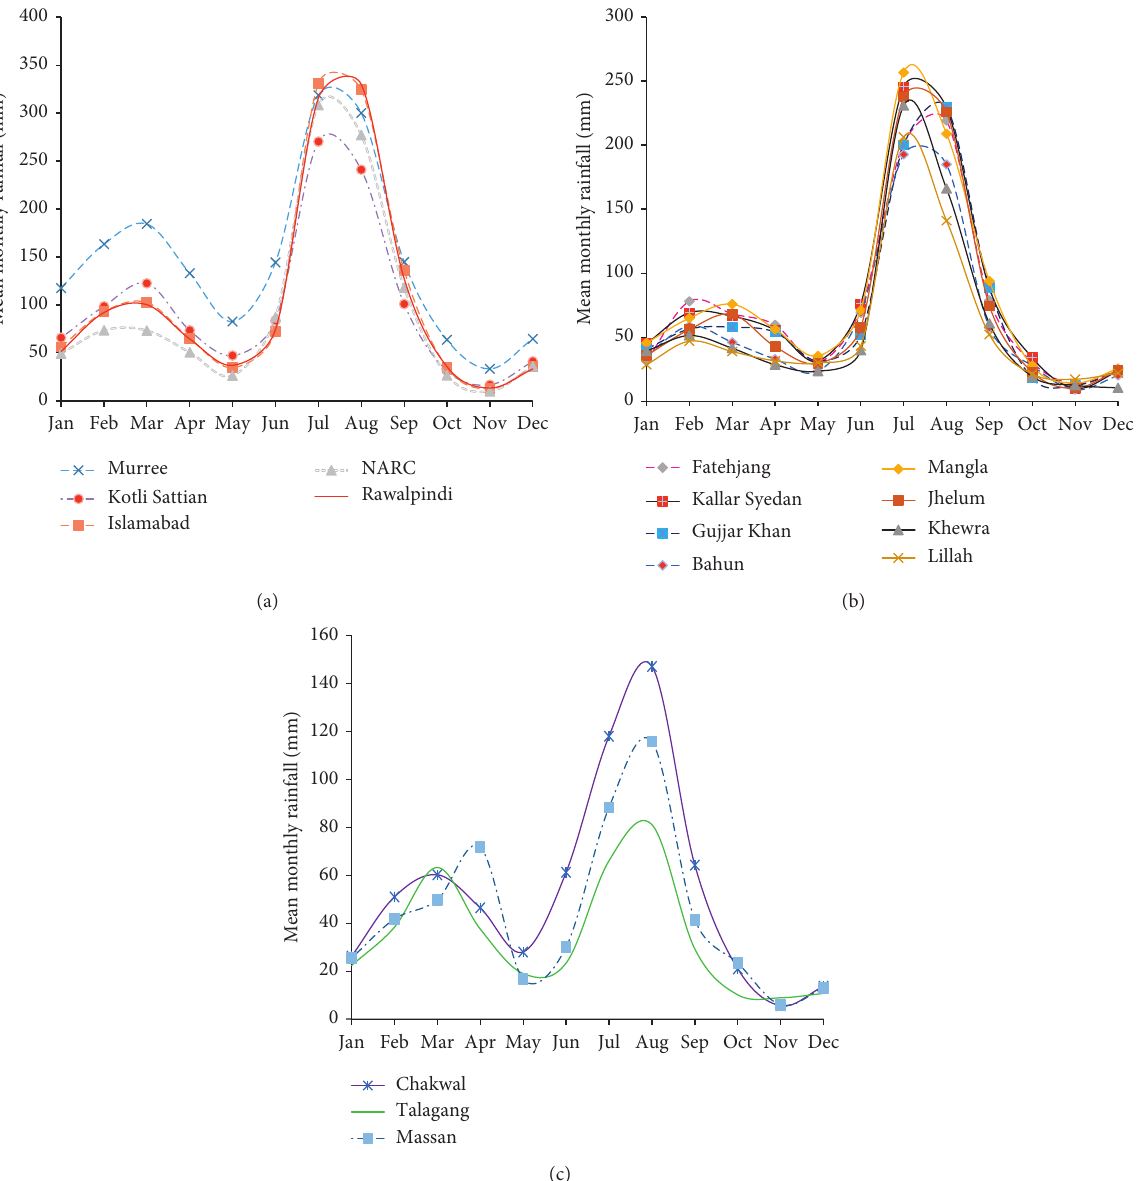
Figure 2: Mean monthly rainfall distribution of Soan River Basin. (a) Highland stations (Murree, Kotli Sattian, Islamabad, Rawalpindi, and NARC), (b) middle-land stations (Kallar Syedan, Gujjar Khan, Fatehjang, Mangla, Jhelum, Lillah, Khewra, and Bahun), and (c) lowlands stations (Chakwal, Talagang, and